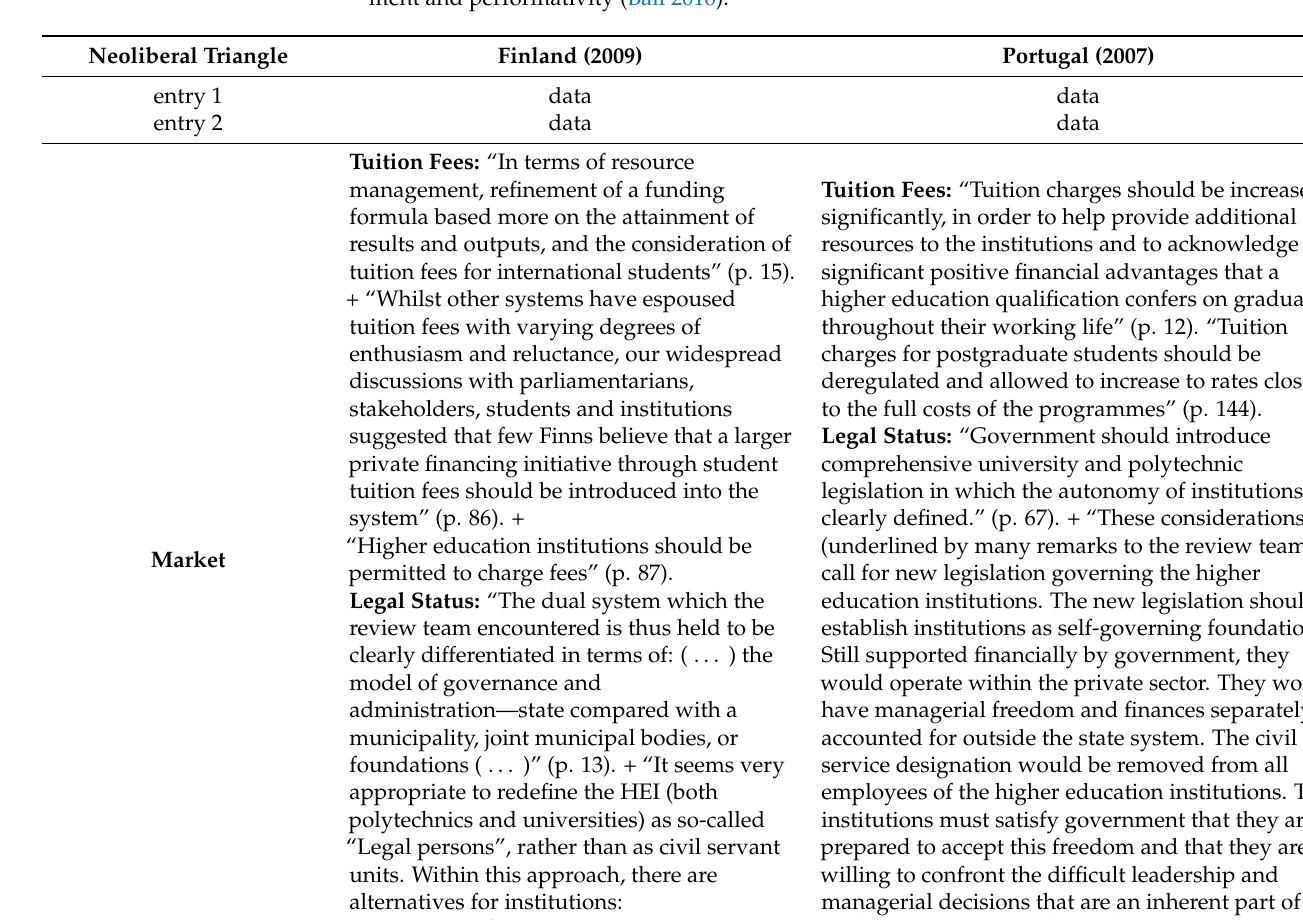
Table A1. Examples on how the OECD proposes neoliberal reforms for the Portuguese and Finnish higher education (HE) systems based on three main components of neoliberalism: market, manage- ment and performativity (Ball